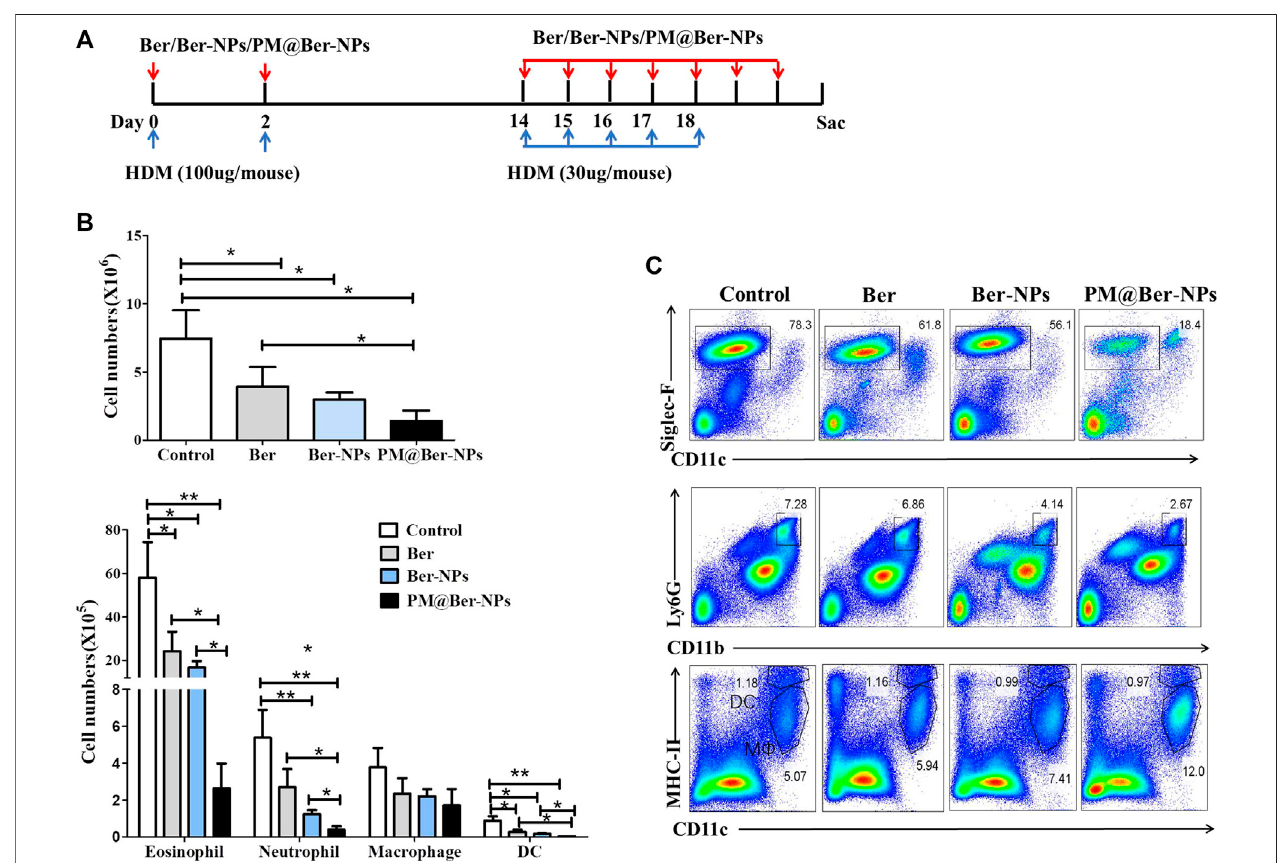
FIGURE 3 | Ber-loaded biomimetic NPs reduce airway cells in fi ltration in HDM-induced mouse asthma. (A) Eight-week-old C57BL/6 female mice ( n (cid:1) 5 mice per group) were subjected to the HDM-induced asthma model. PBS (Control), Ber, Ber-NPs, and PM@Ber-NPs were administered to the mice (as described in Methods). Two days after the last challenge, cells in the BALF sera and lungs were collected to further analysis. (B) Total cell counts, eosinophils, neutrophils, macrophages, and dendriticcells inthe BALF werequanti fi ed. (C) In fi ltrated cellsin theBALF with HDM-inducedasthma( n (cid:1) 5) were isolated and followed by fl ow cytometry analysis. * p < 0.05; ** p <